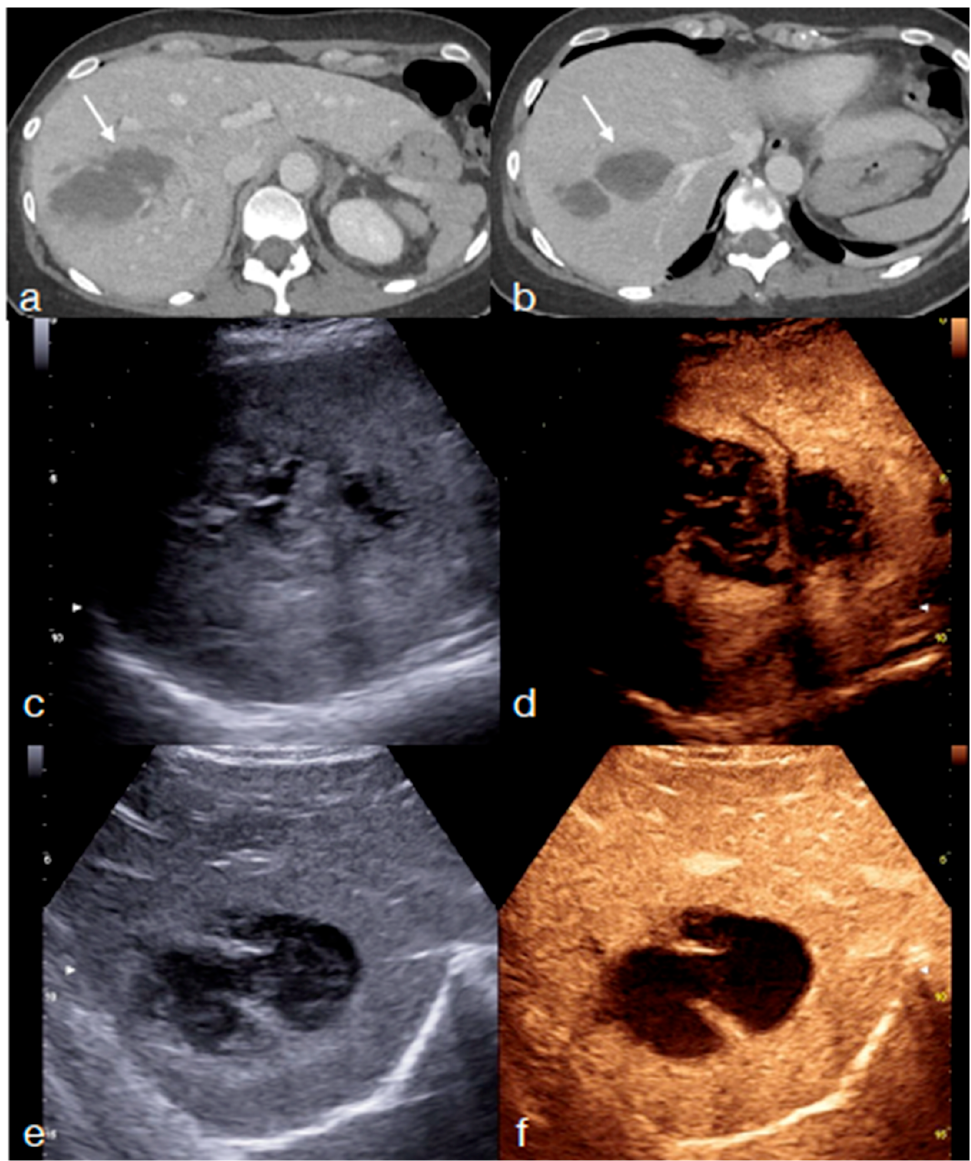
Figure 6. Same patient from Figure 1: once the early lesions stability was confirmed—( a , b arrows) enhanced-CT re-evaluation at 72 h from admission showing an initial healing of the liver injury—it is possible to adopt an imaging method focused on the re-evaluation of the liver injury (most relevant among the patient’ injuries; in this case, CEUS), allowing an optimal parenchymal study. CEUS was performed at 5th (( c ) B-mode and ( d ) CEUS) and 10th (( e ) B-mode and ( f ) CEUS) days showing the progressive healing of the liver laceration, most irregular and inhomogeneous at 5th day ( c , d ), becoming more contained and de fi ned at the 10-day follow-up ( e , f ). It is suggested to have follow-up imaging, especially in patients at higher risks for biliary complications, such as high-grade injury, central hepatic injury and post main he- patic artery embolization, as well as in patients with the onset of non-speci fi c abdominal complaint, developing jaundice or abruptly elevated liver enzymes [7,27].